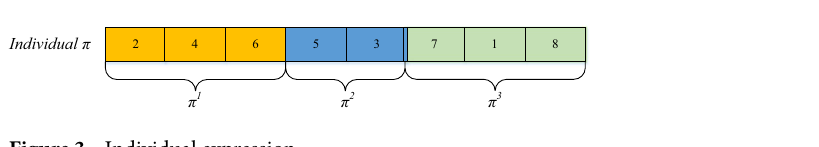
Figure 3. Individual